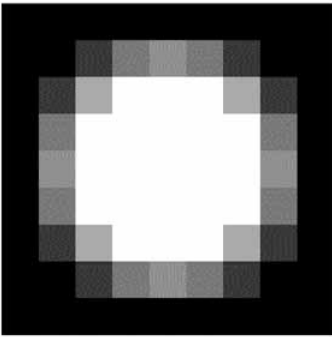
Fig. 3. Neighborhood kernel. Pixel size = 0.5 m.